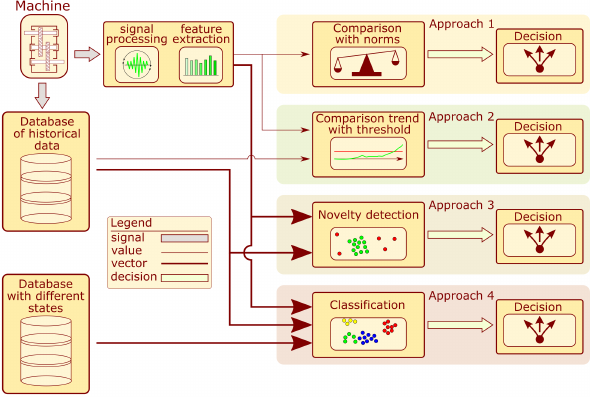
Figure 1. Block diagram of condition assessment system